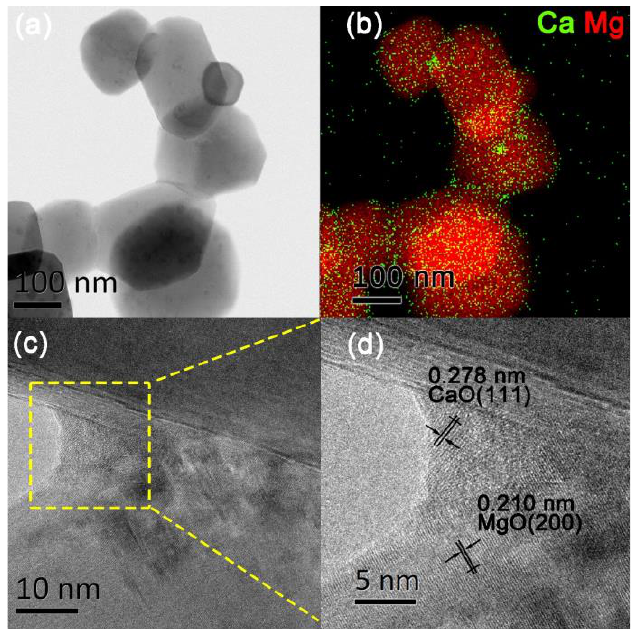
Figure 2. ( a ) TEM images, ( b ) EDS mapping images of Ca and Mg elements, and ( c , d ) high-resolution TEM images of 13.5% CaO/MgO.